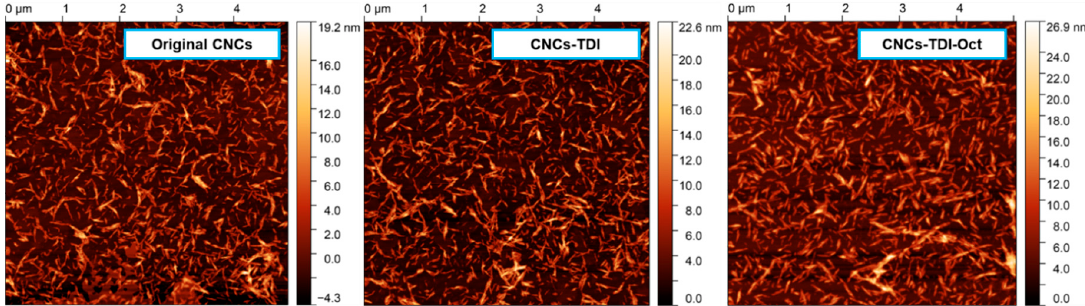
Figure 3. AFM height images of the CNCs before and after surface modification indicating no significant change in the morphology.